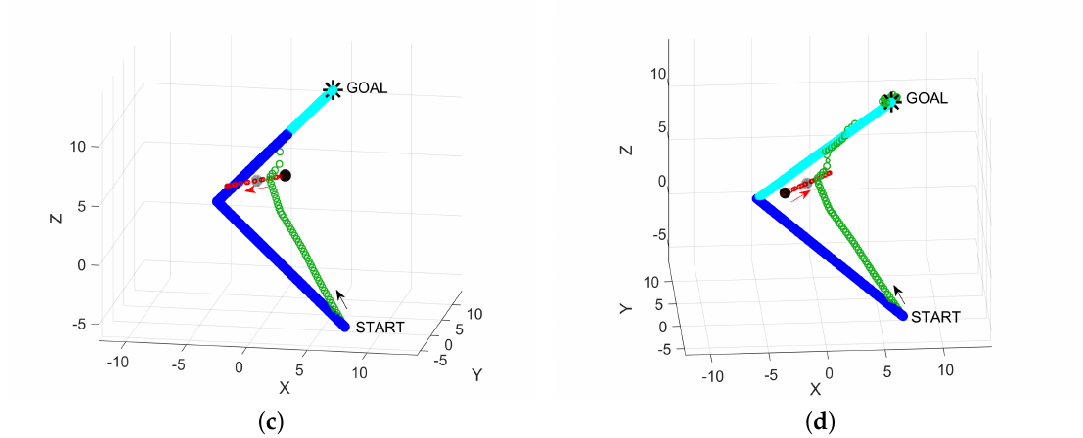
Figure 9. In blue, the starting pose of the robot, while in light-blue, the goal pose. In black, the position of the sphere sphere in the snapshot, while in transparent black, its starting position. In green, the trajectory of the EE. The black arrows show the direction of the movement of the sphere in that snapshot. ( a ) First snapshot; ( b ) second snapshot; ( c ) third snapshot; ( d ) final snapshot.